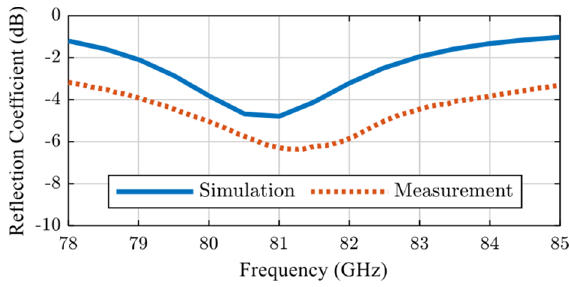
Figure 12. Reflection coefficient of the experimental design of wire-bonded patch antenna.